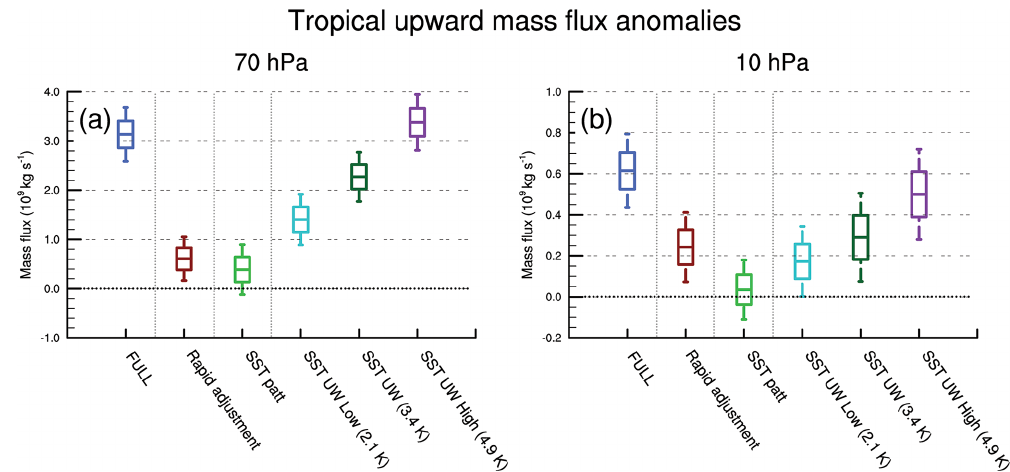
Figure 11. Annual-mean tropical upward mass flux anomalies (10 9 kgs − 1 ) at (a) 70hPa and (b) 10hPa in the different perturbation exper- iments as labelled. The edges of the box plots indicate ± 1SD (standard deviation) of the interannual variability, and the whiskers indicate ±